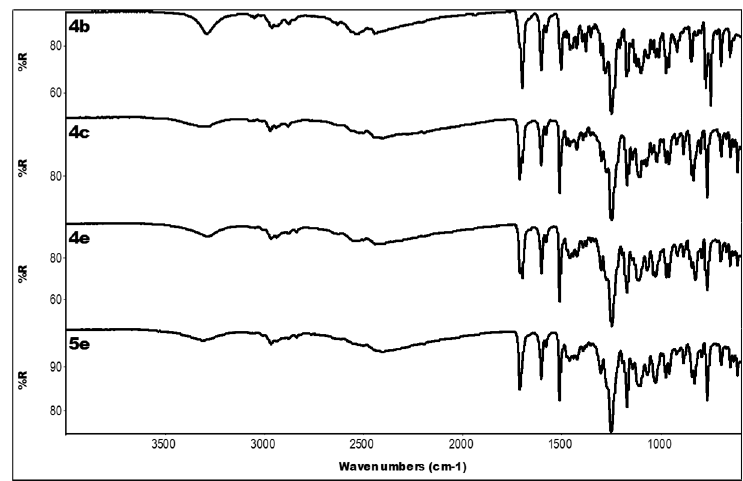
Figure 5. IR spectra of protonated compounds 4b (R = 2-F), 4c (R = 4-F), 4e (R = 4-OCH 3 , equivalent of HCl) and 5e (R = 4-OCH 3 , excess HCl).